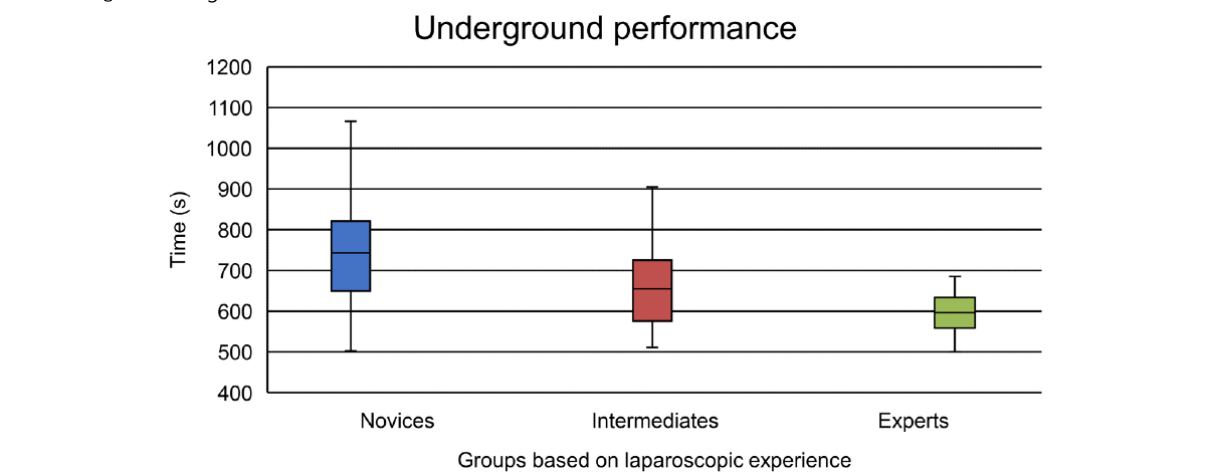
Figure 2. Box plots showing the performance distribution for time between groups. The assessment time is the sum of the time scores for levels 4 and 5 of the serious game Underground